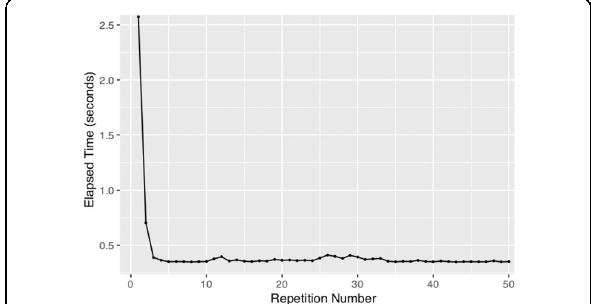
Fig. 1 (abstract 000290). Elapsed time for our example Inform-DB query to run. The query, which runs to return a single week's admissions, quickly falls below 450ms with Postgres